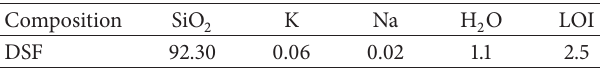
Table 3: Chemical compositions of the silica fume